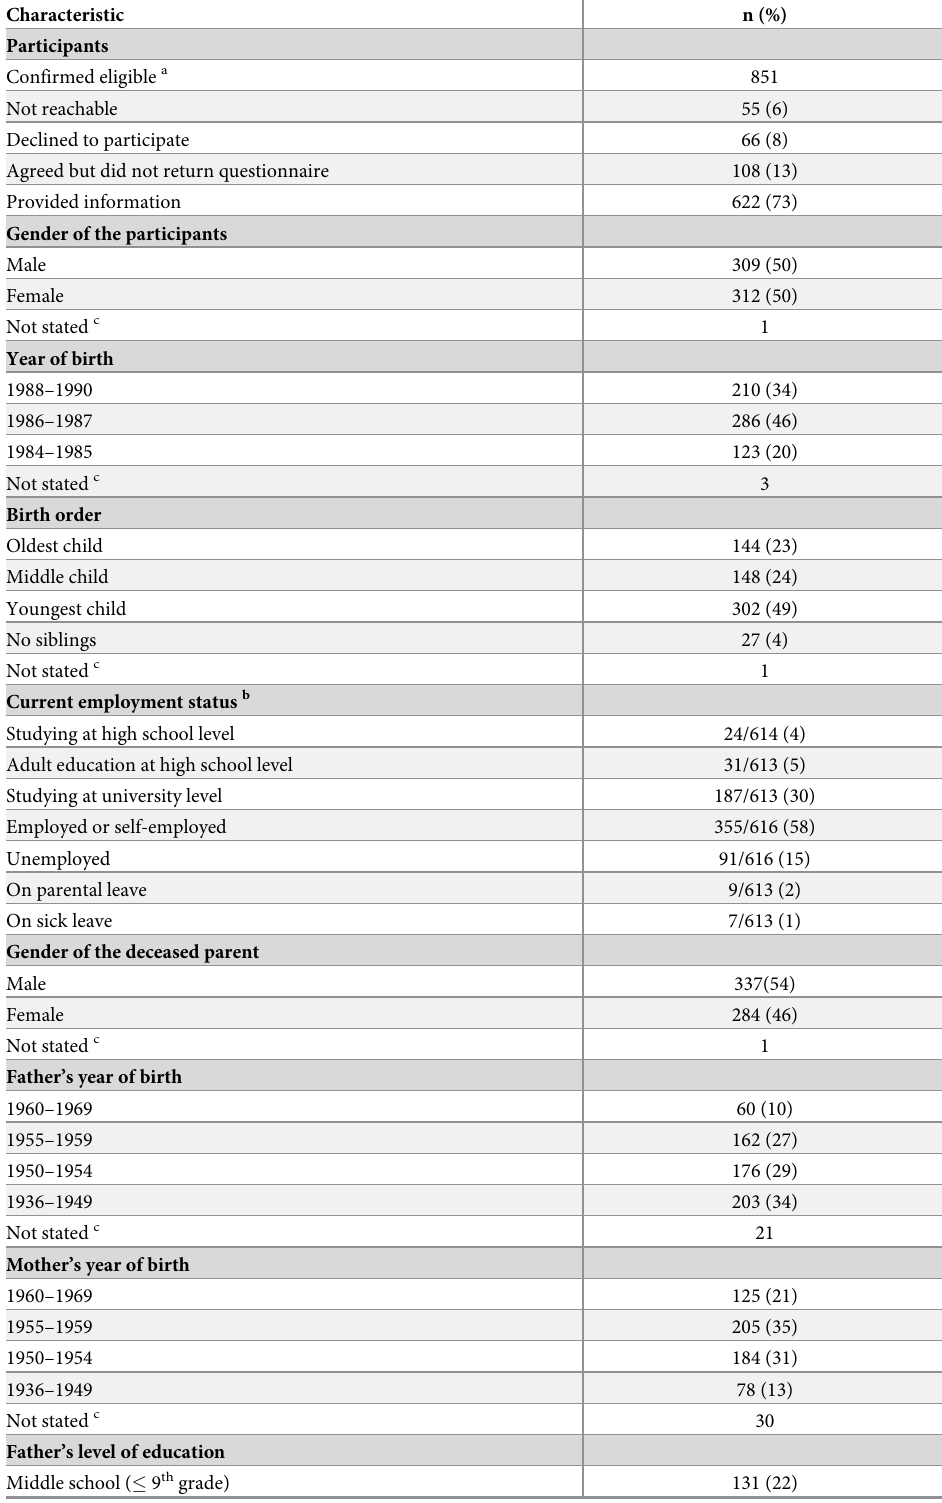
Table 2. Characteristics of the study